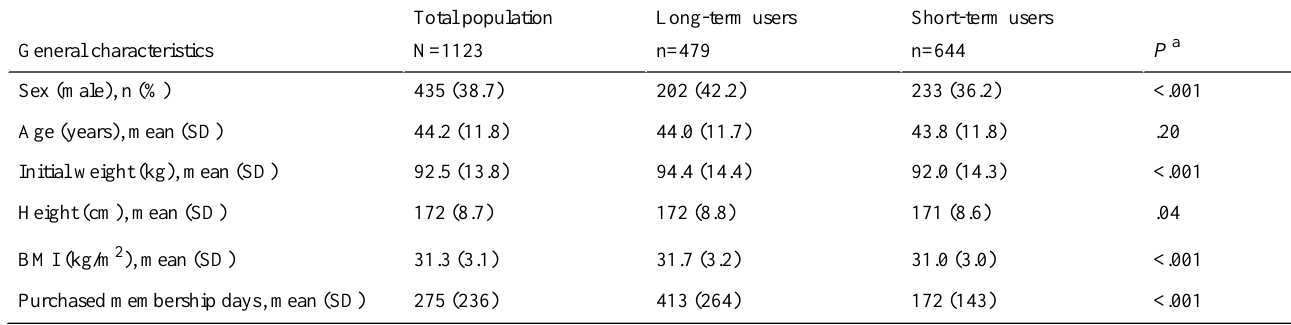
Short-term users n=644Long-term users n=479Total population P a